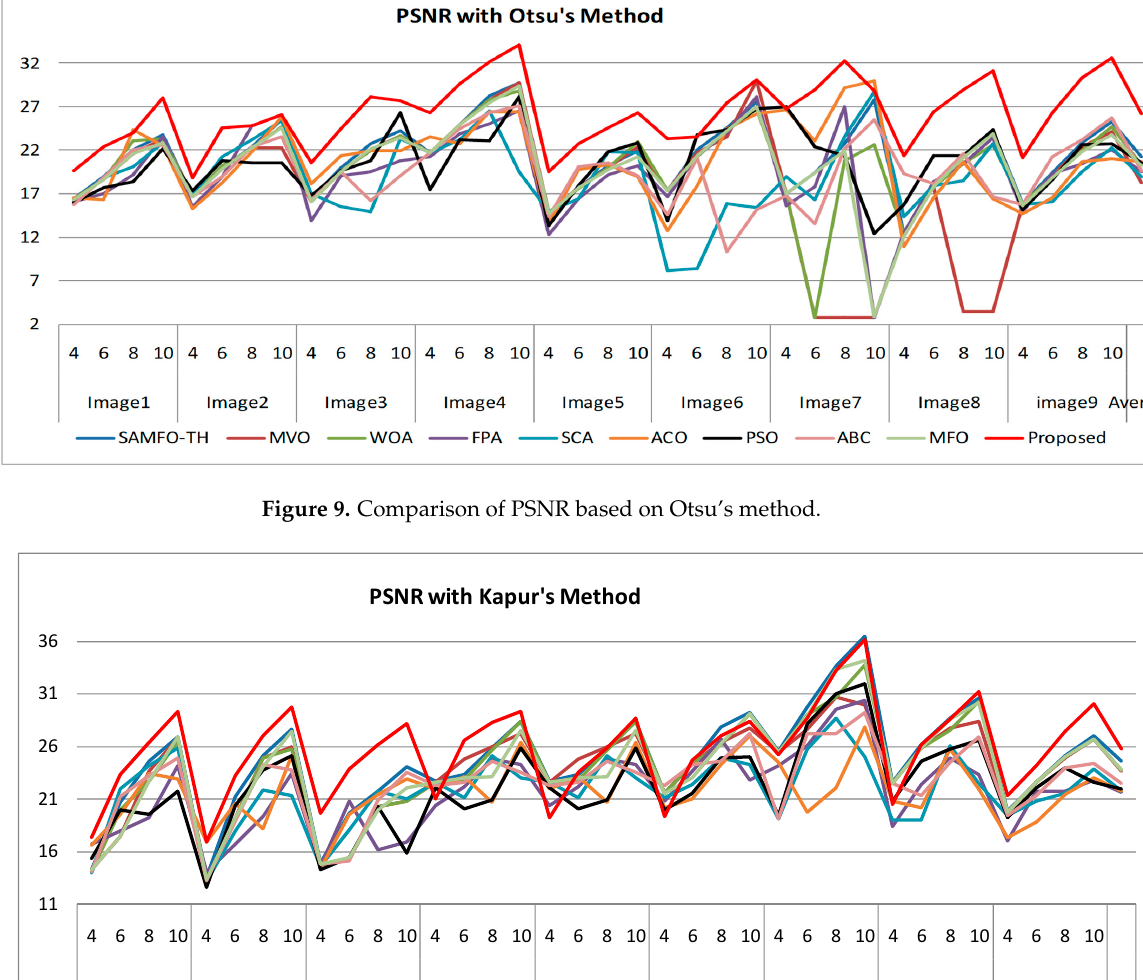
Figure 11. Comparison of SSIM with the proposed method based on Otsu’s and Kapur’s criteria.